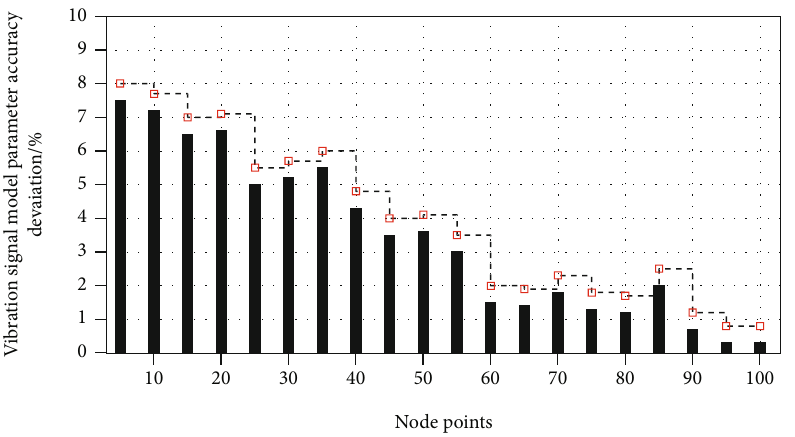
Figure 7: Ladder diagram of parameter accuracy deviation of vibration signal model.